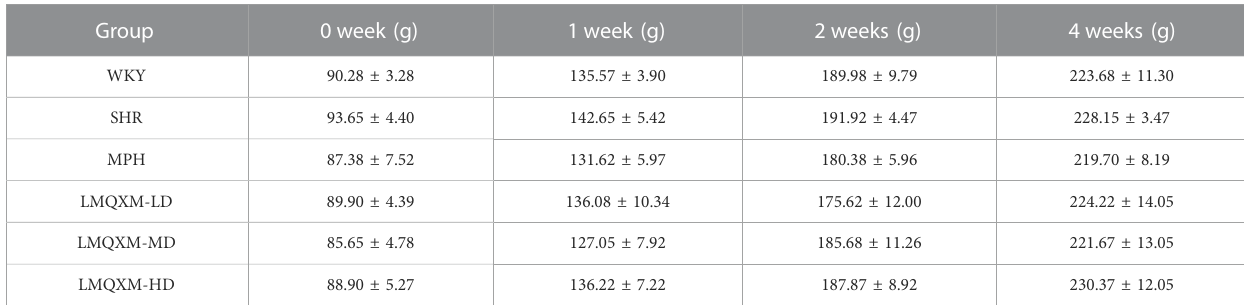
TABLE 7 Changes in weight of rats in each